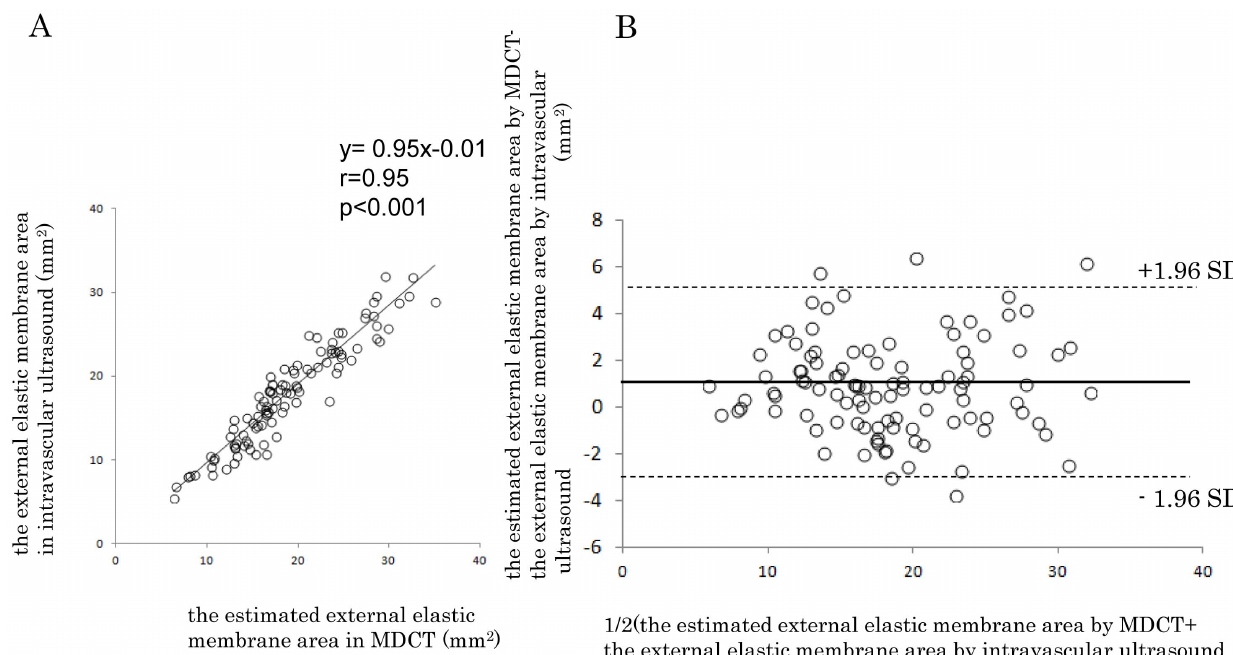
Figure 5. The correlation between the estimated and the measured EEM area (A), and Bland-Altman plot (B).